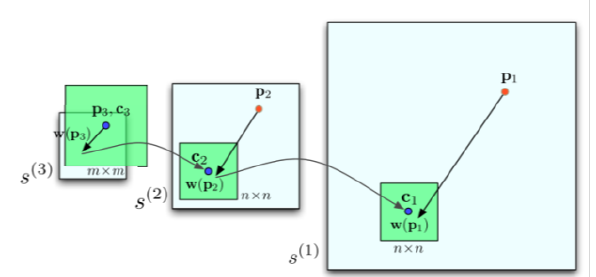
Figure 1. Top-down matching scheme used in SIFT flow (Liu et al., 2011)